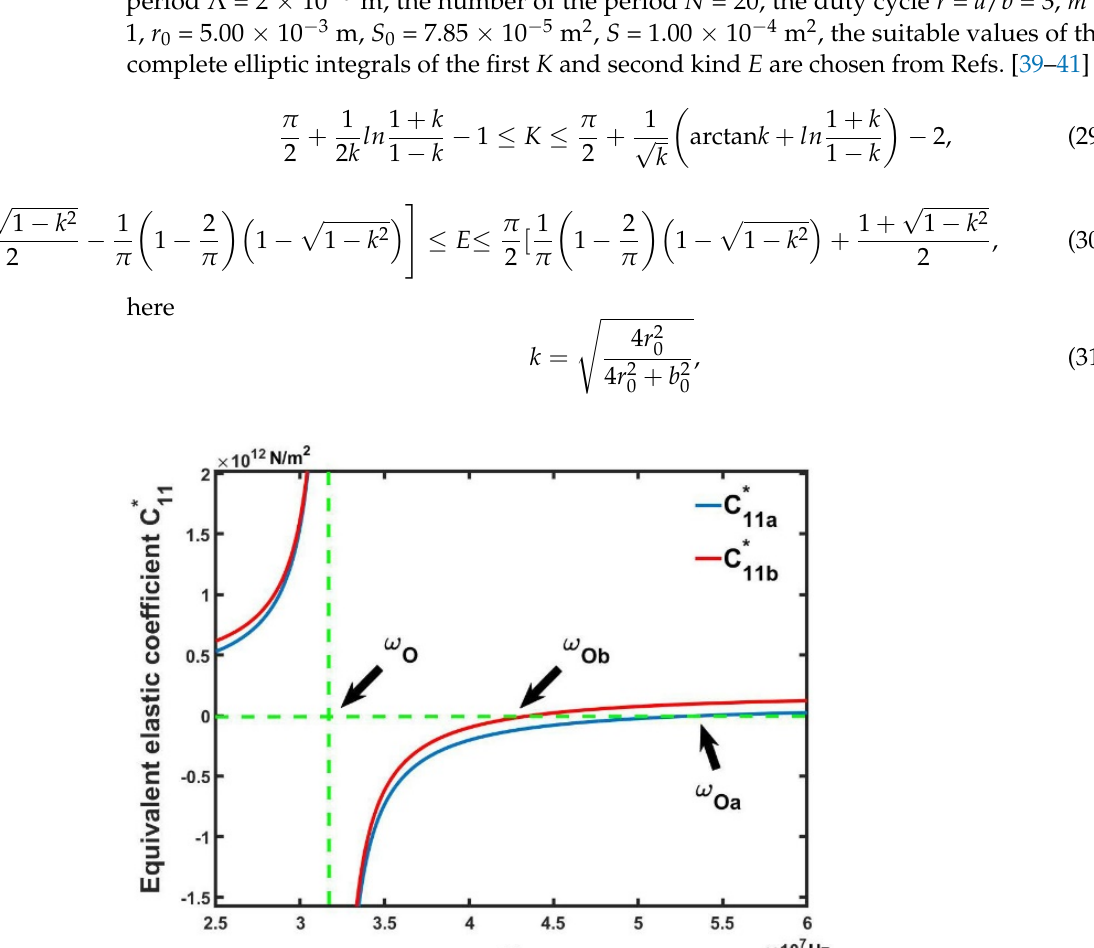
and C ∗ . The functions 11 a 11 b